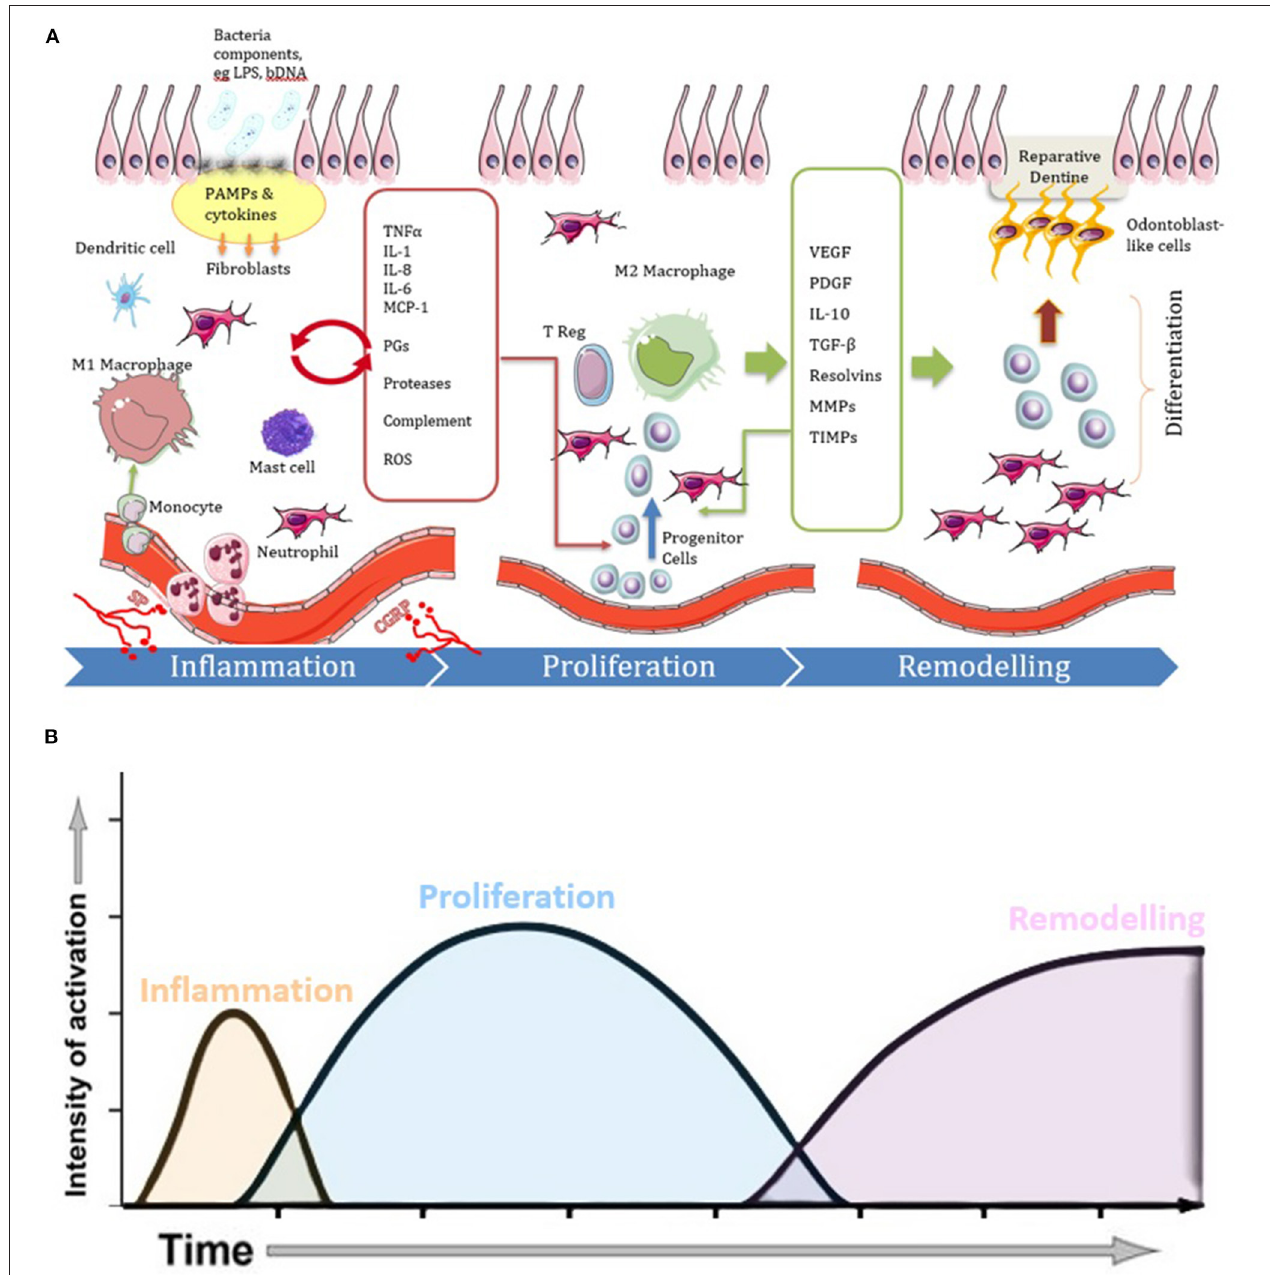
FIGURE 1 | Diagrams illustrating the three phases of the repair process in pulpitis, showing (A) cell and molecular involvement and (B) temporal dynamics. Following carious infection and lesion progression the inflammatory phase becomes characterized by vasodilation and increased migration of immune cells (e.g., monocytes, macrophages, dendritic cells, mast cells and neutrophils) in response to cytokines and other chemotactic signals released by tissue resident cells in response to PAMPs. The cytokines and chemokines act via paracrine signaling (red arrow) to amplify the inflammation. Neuronal tissues also release neurotrophic factors, such as SP and CGRP, which also influence the course of the inflammatory and healing reactions. When the infection is under control, the inflammatory process begins to resolve and there is an increase in cells and molecules which act in an anti-inflammatory manner. Many of the cytokines which drove the inflammatory response along with newly expressed molecules promote proliferative responses as the disease context changes toward a healing response. M2 macrophages are also evident which promote inflammation resolution. Proliferation and migration of stem/progenitor cells continue to complete the healing process by the differentiation of new pulp tissue and odontoblast-like cells that produce reparative dentine during the remodeling phase.